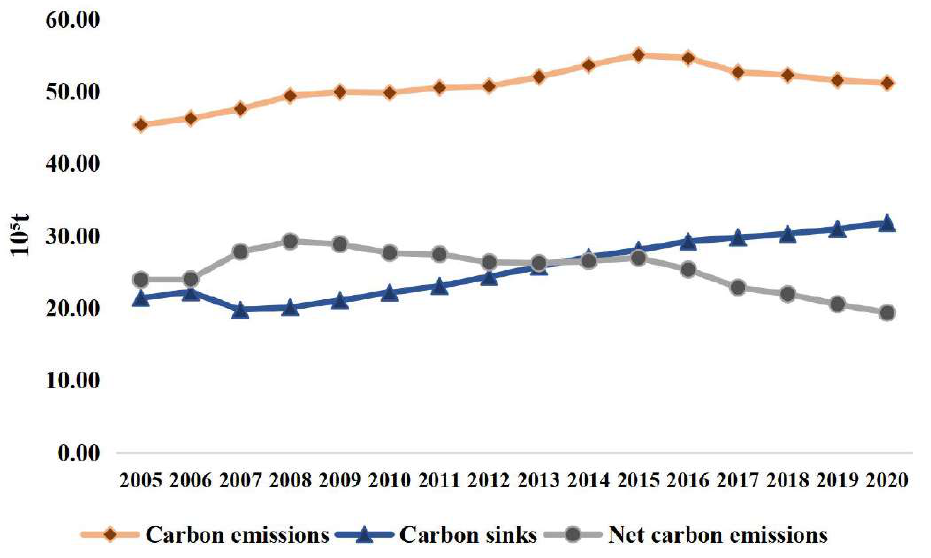
Figure 1. Changes in marine fishery carbon emissions, carbon sinks, and net carbon emissions from 2005 to 2020 (10 5 t/year).